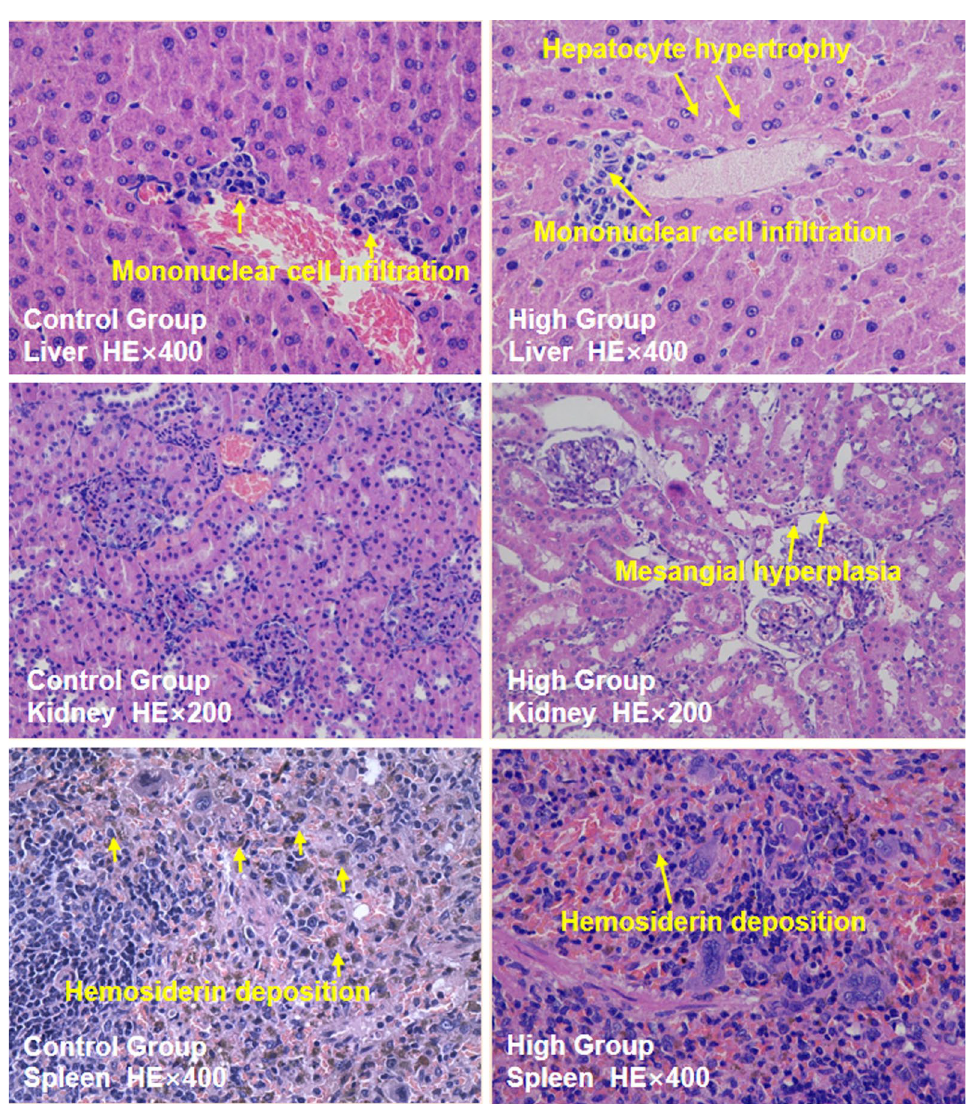
Fig. 4 Typical pathology of important organs in the histopathological analysis of rats exposed to high-dose maleic acid polymer scale inhibitor 5). Mononuclear cell infiltration and hepatocyte hypertrophy in the liver, mesangial hyperplasia in the kidney, and (1/5 LD 50 ) for 90 days ( n = hemosiderin deposition in the spleen are shown by the arrows. After HE staining, liver and spleen tissues were observed at 400 was observed at 200 under an optical ×